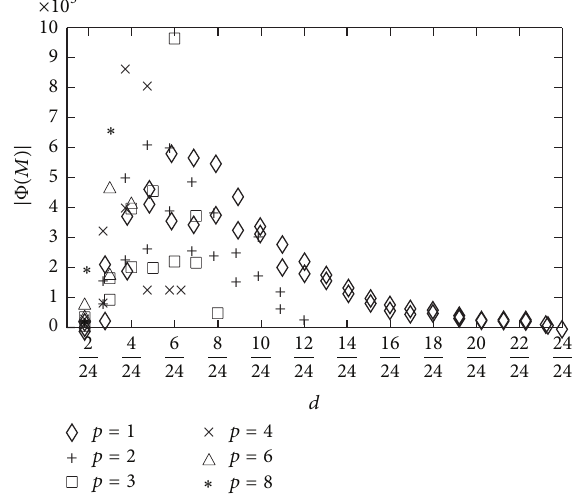
and 1 gigabyte main memory, running Windows XP.